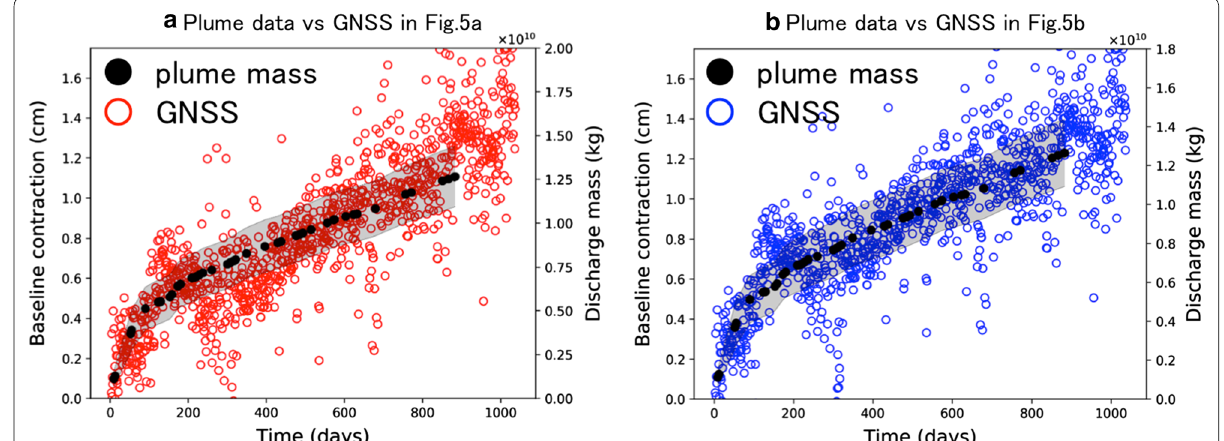
Fig. 6 Comparison between the discharge mass and the baseline contraction in Fig. 5a, b, respectively. Gray-shaded areas indicate range of estimated error of the discharge